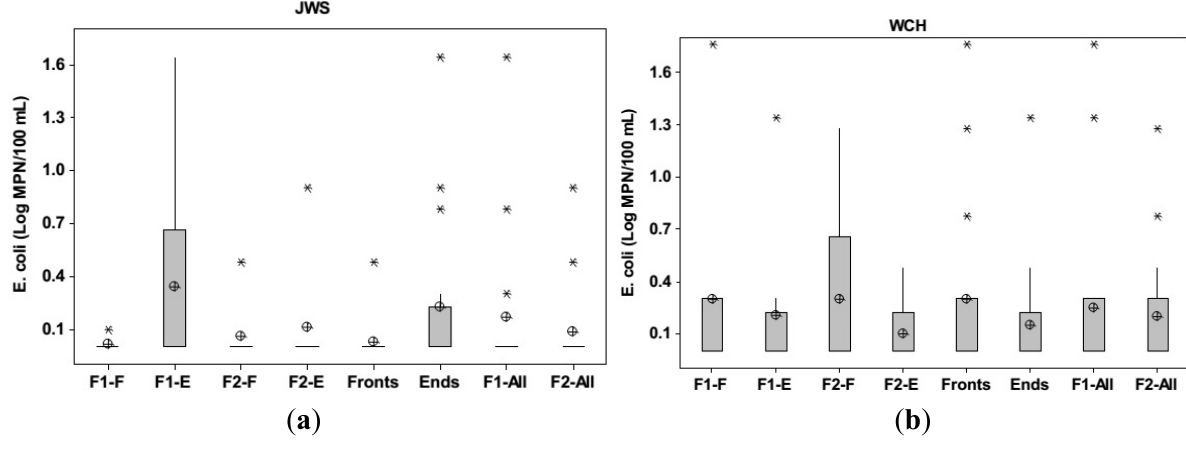
Figure 6. E. coli concentrations (Log MPN/100 mL) in groundwater beneath the drainfield trenches at James W. Smith ( a ) and West Craven High ( b ). Field 1 is F1, Field 2 is F2, front of the field is F, end of the field is E. Data indicate that the E. coli concentrations were more variable at James W. Smith relative to West